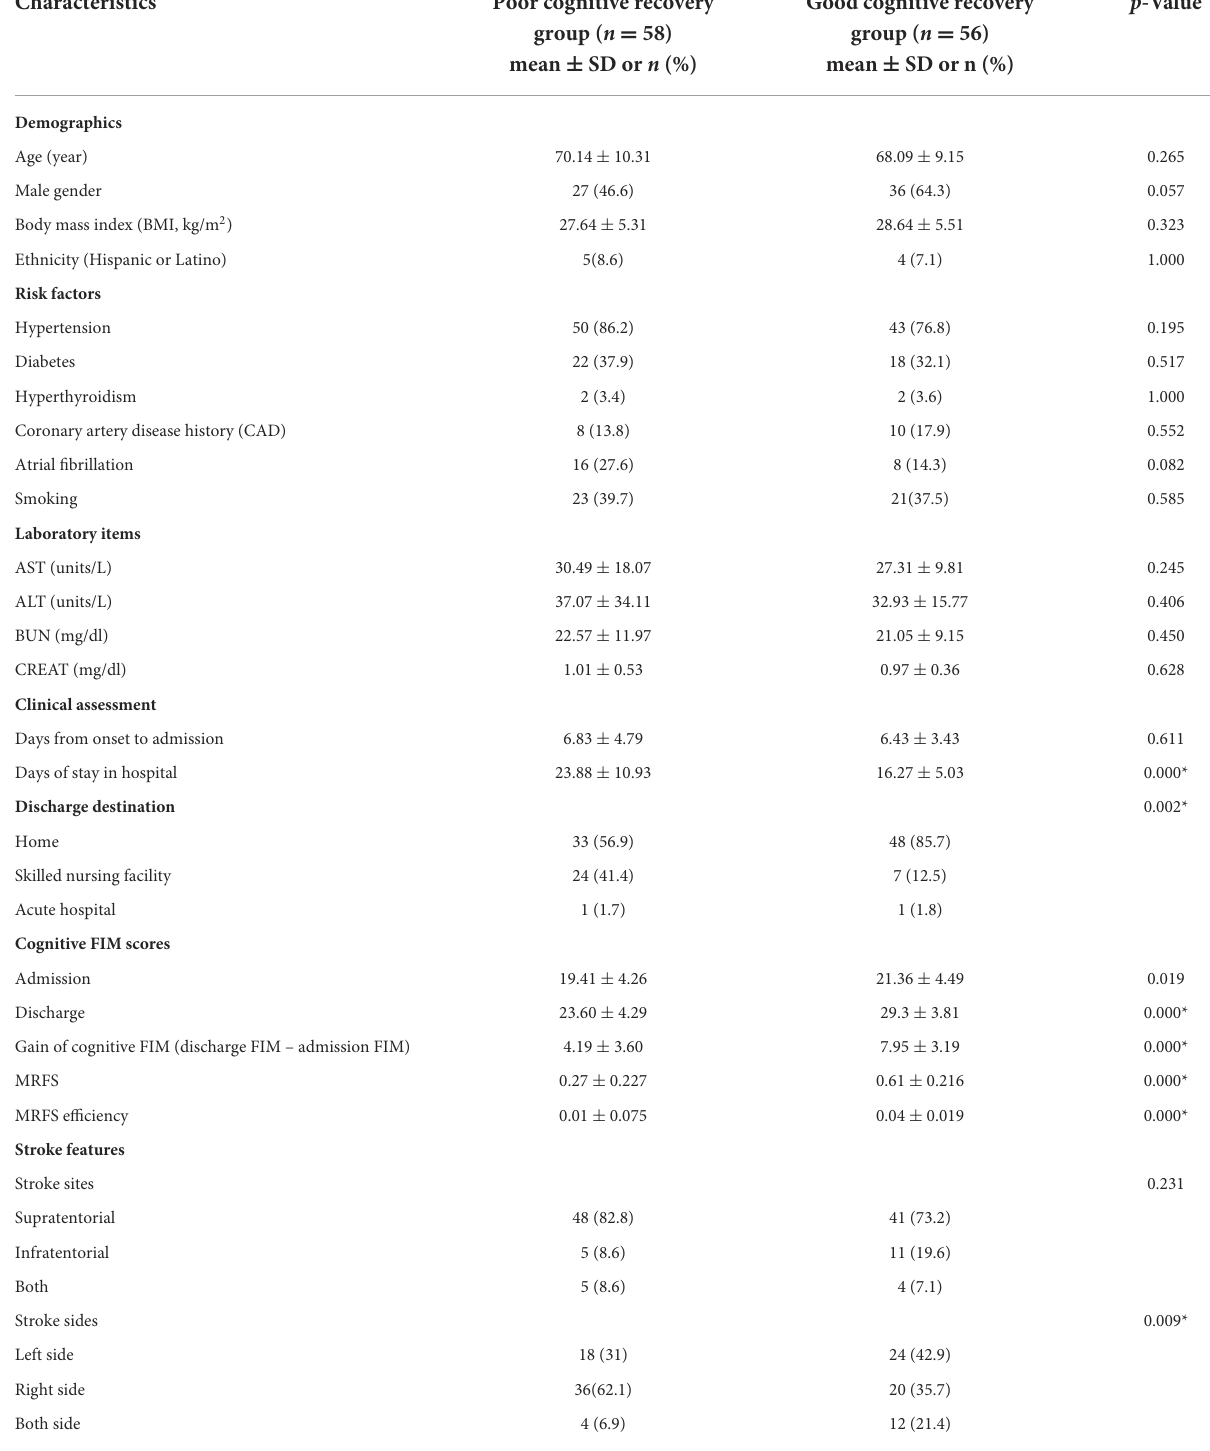
TABLE 1 The clinical characteristics of patients with ischemic stroke.